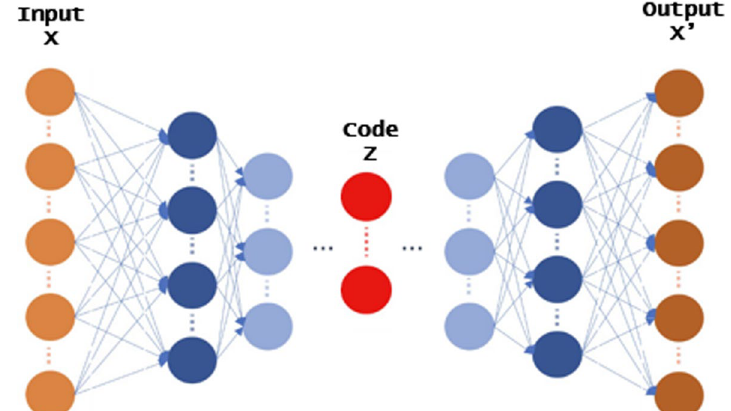
Fig. 2 Schematic structure of an Autoencoder